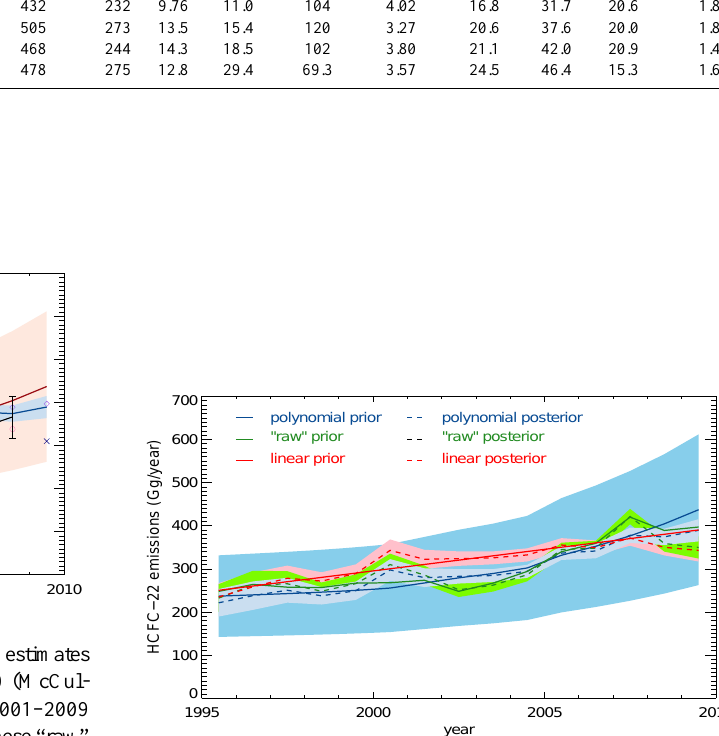
Fig. 4. Global total prior (solid lines) and posterior (dash lines) HCFC-22 emissions using the following three sets of a priori emis- sions: polynomial fit prior (blue), “raw” prior (green), and linear fit prior